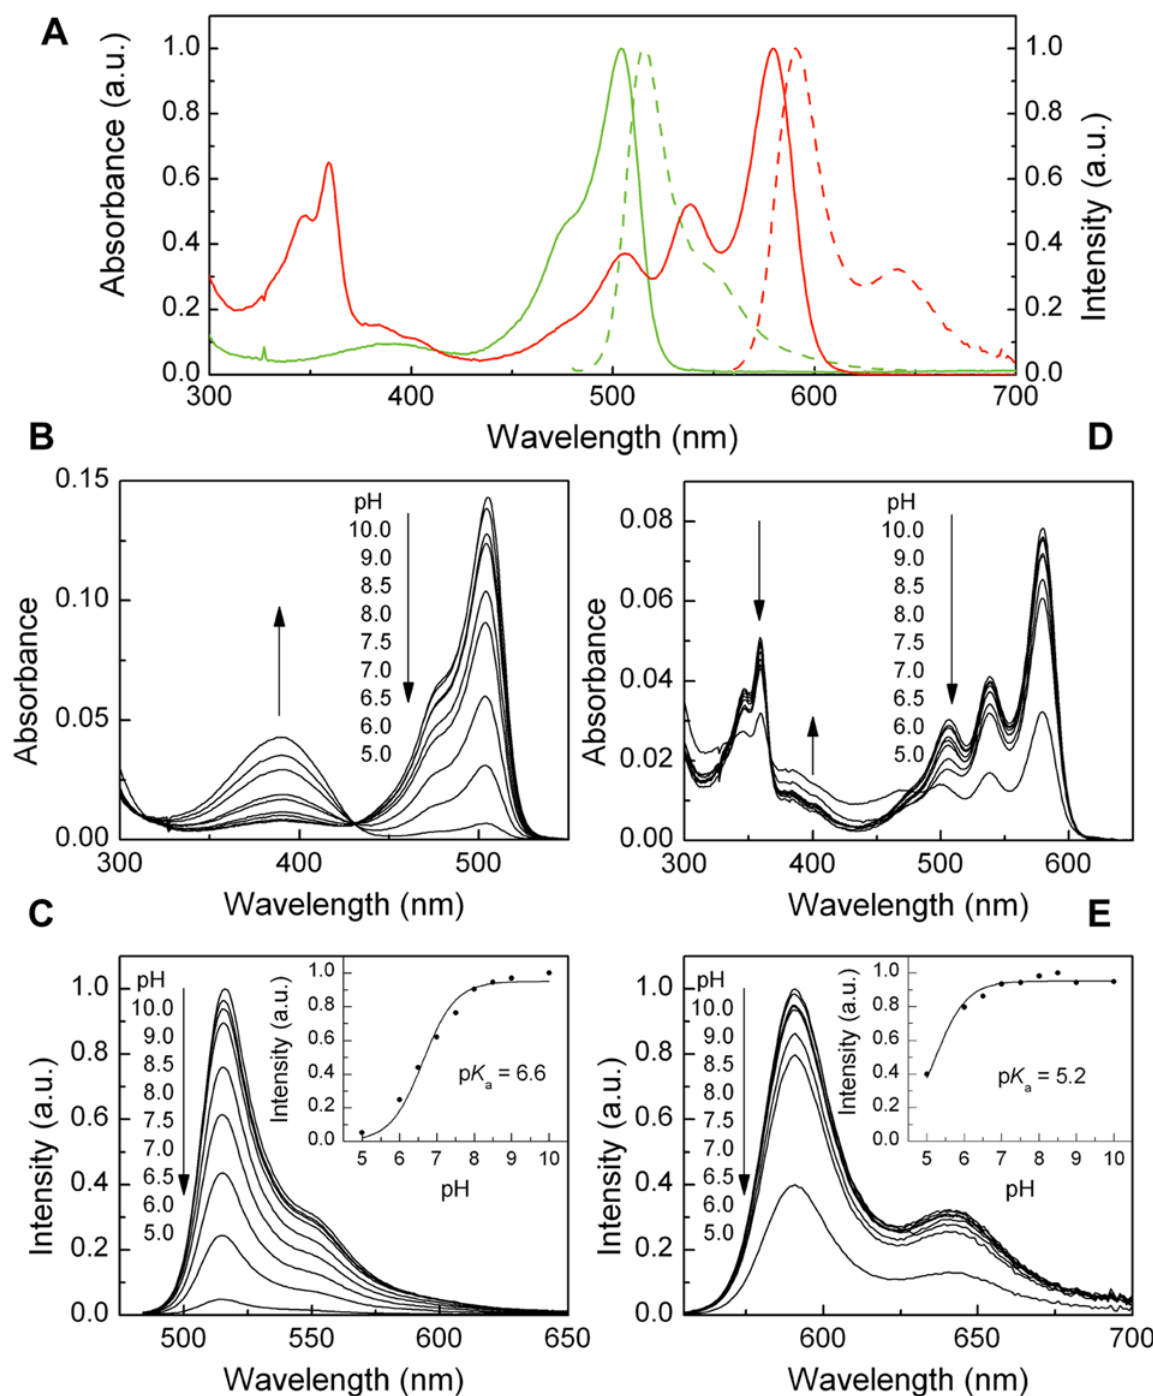
Figure 2. Spectroscopic properties of the green and red form of mKikGR. (A) Normalized absorption (solid line) and fluorescence (dashed line) spectra of the green mKikGR (4.7 m M, green line) and red mKikGR (4.7 m M, red line). The red mKikGR was obtained by illuminating at 405 nm (12 mW cm 2 2 ) for 90 minutes. Fluorescence spectra of the green and red mKikGR were measured with 475 nm and 555 nm excitation, respectively. All measurements were performed at pH 8.0. (B, D) pH dependence of absorption spectra of the green (B) and red (D) mKikGR (4.7 m M). (C, E) pH dependence of fluorescence spectra of the green (C) and red (E) mKikGR (4.7 m M). Fluorescence spectra of the green and red mKikGR were measured with 475 nm and 555 nm excitation, respectively. (Inset) Peak fluorescence intensities at different pH. The solid lines show fitting with the Henderson- Hasselbalch equation.